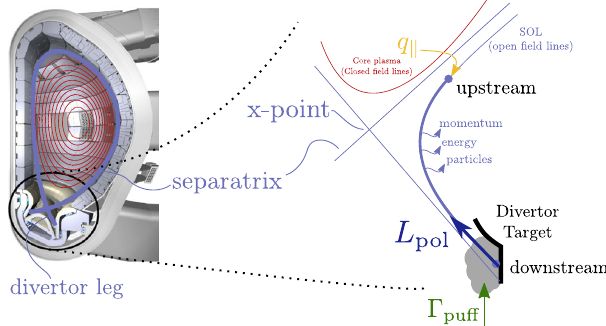
Fig. 1 Detachment in a tokamak divertor plasma. Left: Diverted plasma con fi guration in a tokamak with schematic poloidal fl ux surfaces. The con fi ned region (red curves) is separated from the open fi eld line or scrape- off-layer (SOL) region by the separatrix, shown as a thick blue line. Right: Summary of the relevant aspects of the detachment process. High heat fl uxes densities q ∥ along the SOL fi eld lines are mitigated by a gas buffer, which is controlled by local gas puf fi ng Γ puff . This causes a combination of volumetric loss processes (e.g., momentum, energy, and particle losses), resulting in signi fi cantly lower downstream target pressures and temperatures compared to the upstream conditions. These conditions give rise to the formation of emission fronts. The distance along the divertor leg to the target of the impurity emission front (the arc length) is denoted by L pol . (Cross-sectional mock-up reproduced from: (c) ITER